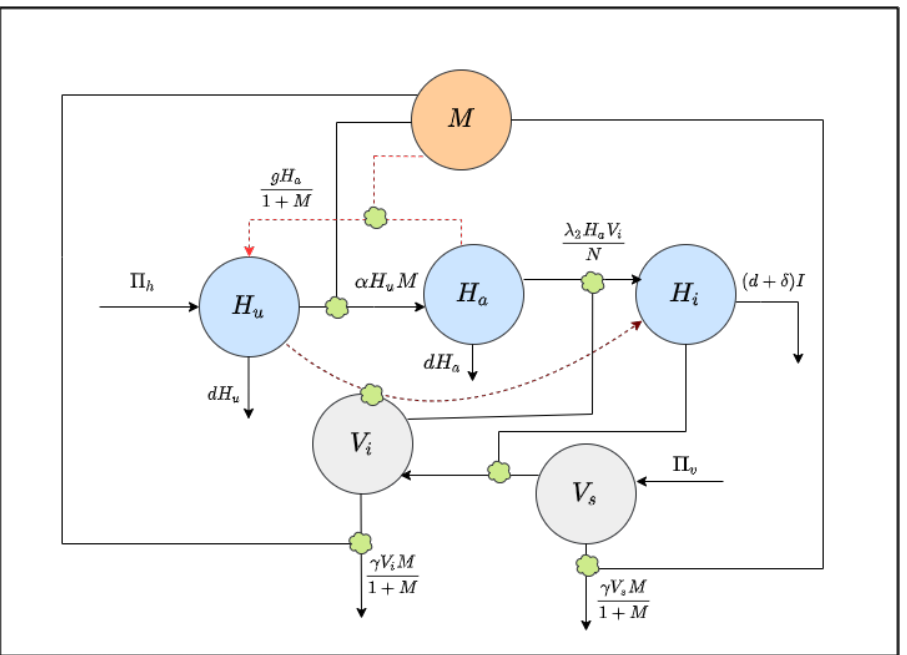
Figure 1. Schematic diagram of the model (1): interactions between model populations are